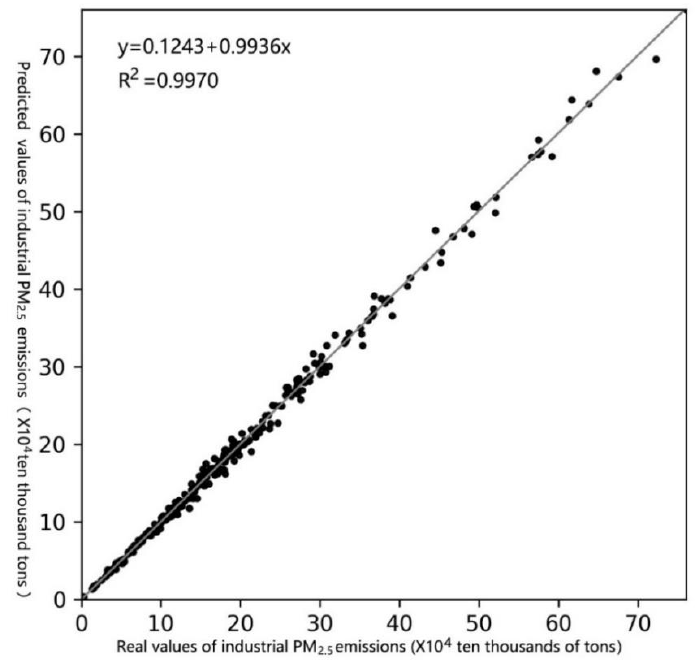
Figure 2. Scatters and fitting line of real and estimated industrial annual total 𝑃𝑀 2.5 emissions of the 31 provincial regions in mainland China from 2013 to 2017.